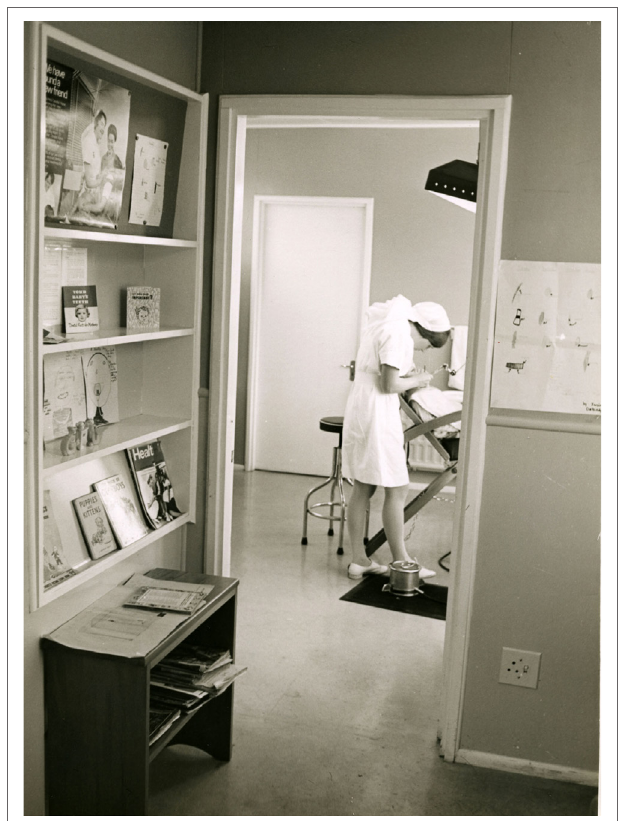
FiguRe 7 | Dental clinic and dental nurse, 1970s [Archives New Zealand/Te Rua Mahara o te Kawanatanga, Wellington Office (Archives Reference: ABKI W4078 667/3)]. Cuts to health funding from the late 1970s meant that the School Dental Service had difficulties in keeping up-to-date with modern procedures, e.g., the introduction of block anesthesia and radiography, and less money was available for new dental materials and modern equipment. Poor working conditions and a lack of career progression would lead to dissatisfaction within the workforce. What had once been an innovative service was rapidly becoming outdated